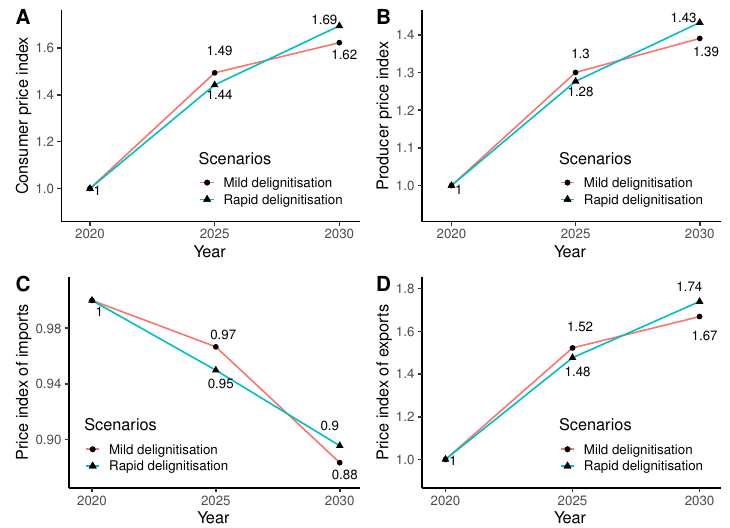
Figure 3. Graphical display of the evolution of the Consumer Price Index (CPI; plot A ), the Producer Price Index (PPI; plot B ), the price index of imports (plot C ), and the price index of exports (plot D ) over the 2020–2025 and 2026–2030 periods under the mild and rapid delignitization